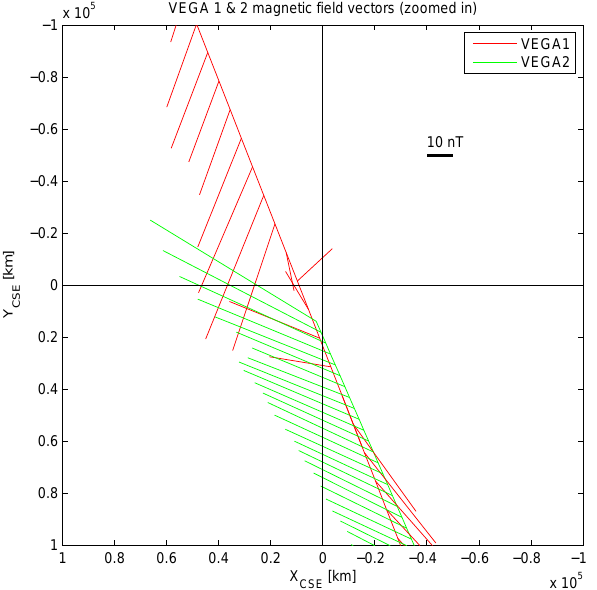
Figure 16. Vector plots of the low-pass filtered magnetic field for VEGA 1 (red) and 2 (green), zoomed in on the inner 10000 km around the cometary nucleus. VEGA 2 enters well into the region where VEGA 1 shows changes in the sign of B x , but VEGA 2 shows only one sign of B x .